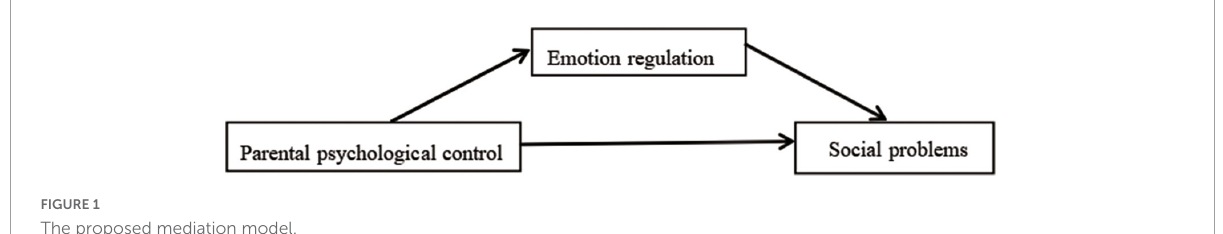
FIGURE1 The proposed mediation model.